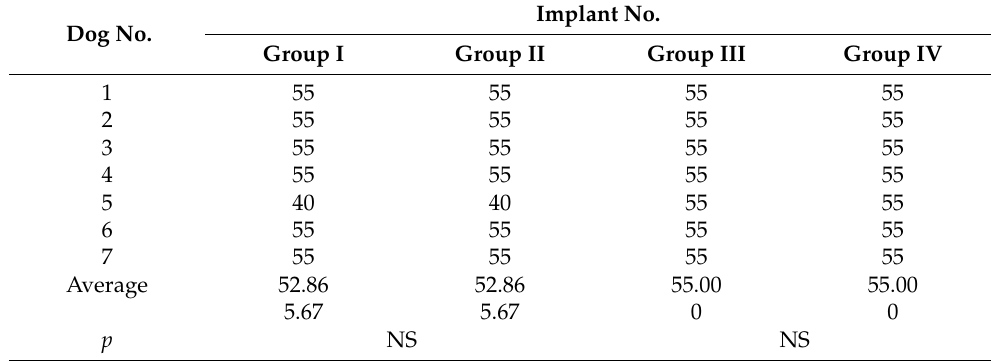
Table 1. Insertion torque